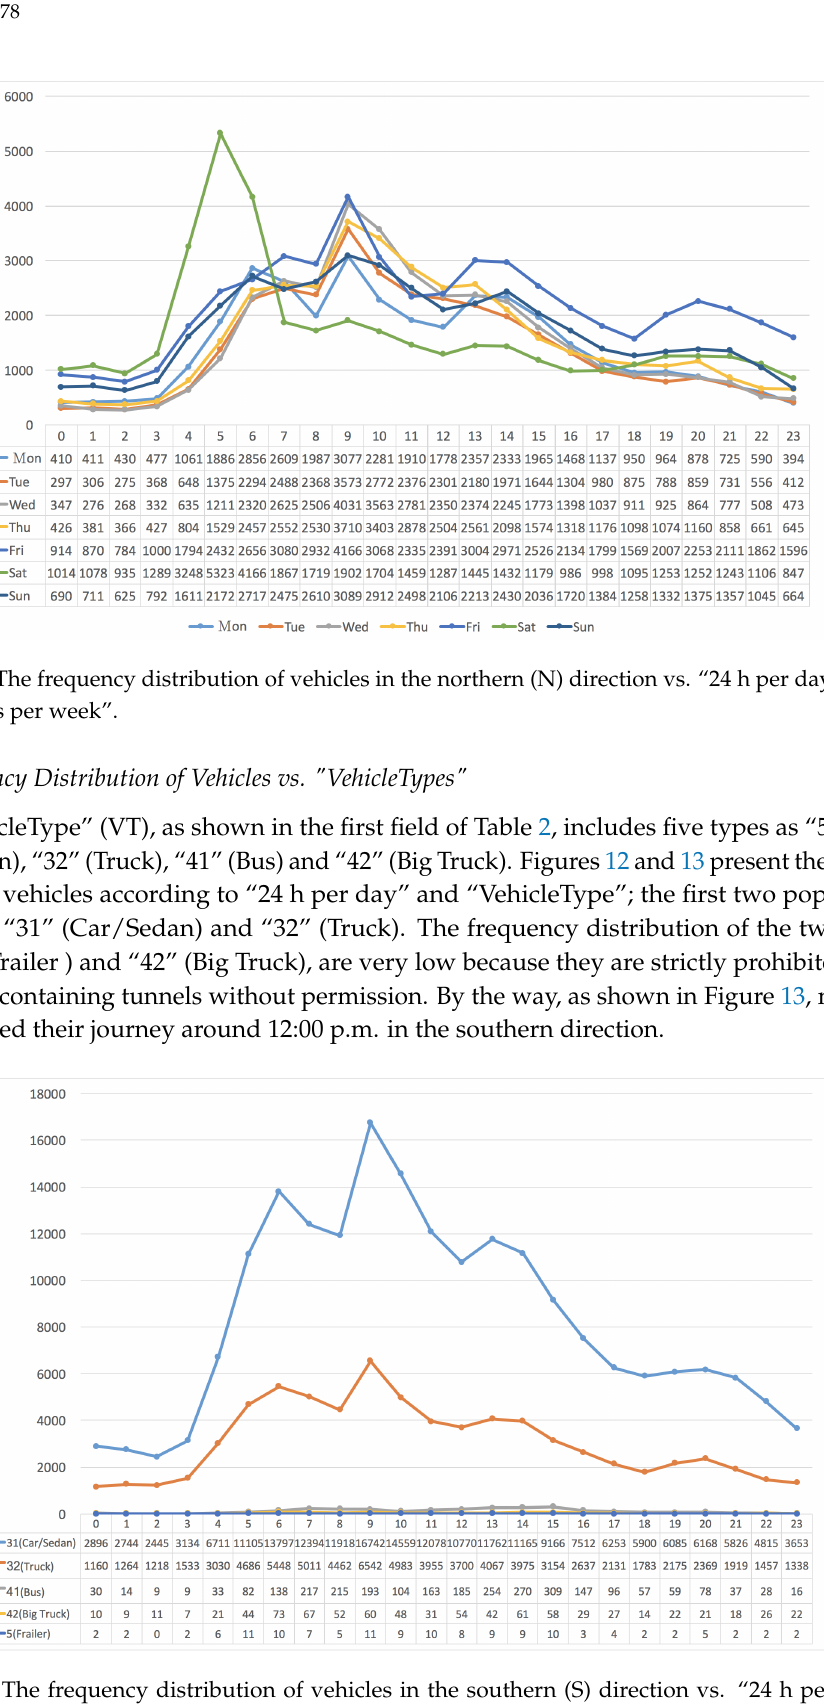
Figure 12. The frequency distribution of vehicles in the southern (S) direction vs. “24 h per day” and